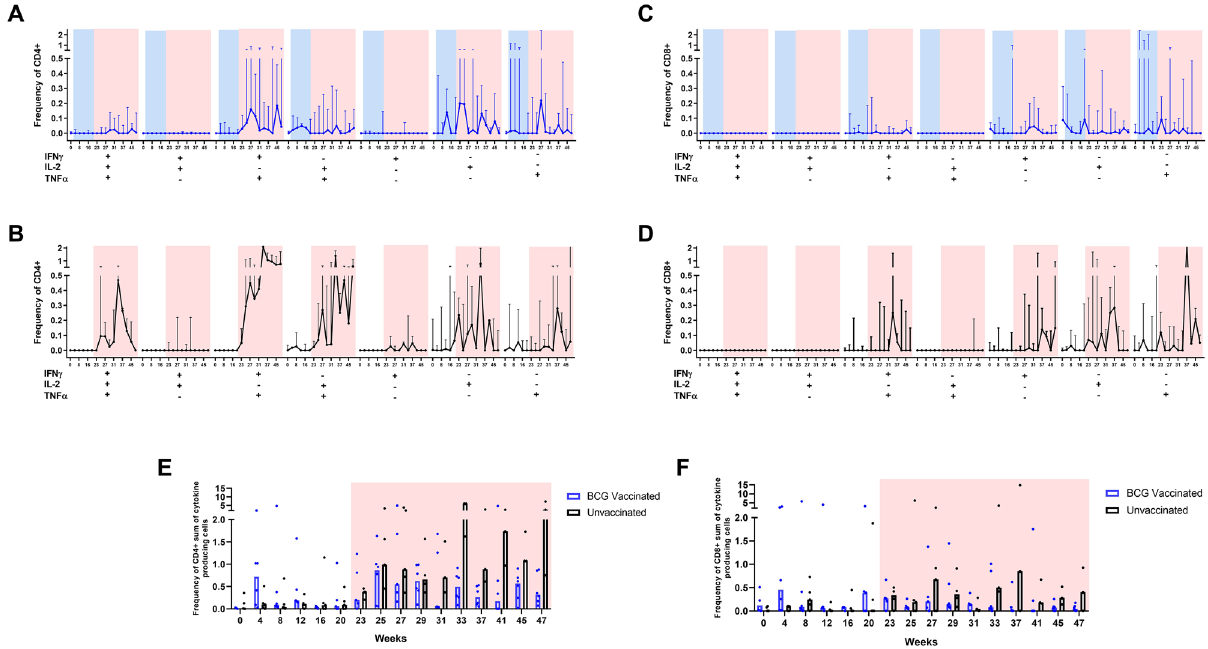
Figure 3. PPD-specific polyfunctional T-cell analysis of CCM with or without BCG vaccination and challenged with MTB at week 21. ( A ) CD4 + T-cells: vaccinated with BCG (n = 6), ( B ) CD4 + T-cells unvaccinated (n = 6 to week 25, n = 5 to week 27, n = 4 to week 29 then n = 3 to week 47). ( C ) CD8 + T-cells, vaccinated with BCG (n = 6). ( D ) CD8 + T-cells unvaccinated (n = 6 to week 25, n = 5 to week 27, n = 4 to week 29 then n = 3 to week 47). ( E ) Summed cytokine responses in CD4 + T-cells, ( F ) summed cytokine responses in CD8 + T-cells. Median baseline response determined from assays applied on three separate occasions prior to vaccination. Vaccination phase in blue, challenge phase in red. Interquartile range shown and black line indicates median response. Black dots show individual responses. Frequency of parent combinations of IFNγ, IL-2 and TNFα. Threshold of 0.05 (75% confidence interval). Asterisks denote significant differences between the vaccinated group and controls animals determined by Mann–Whitney test (*p ≤